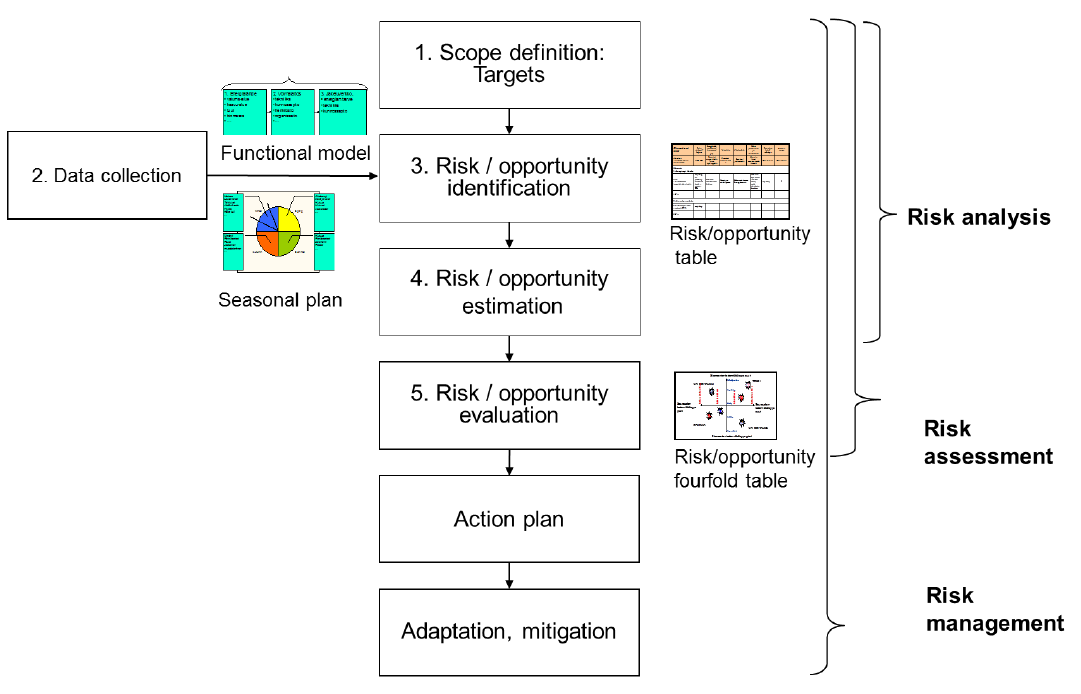
Figure 4. Risk assessment method for assessing future risks derived from